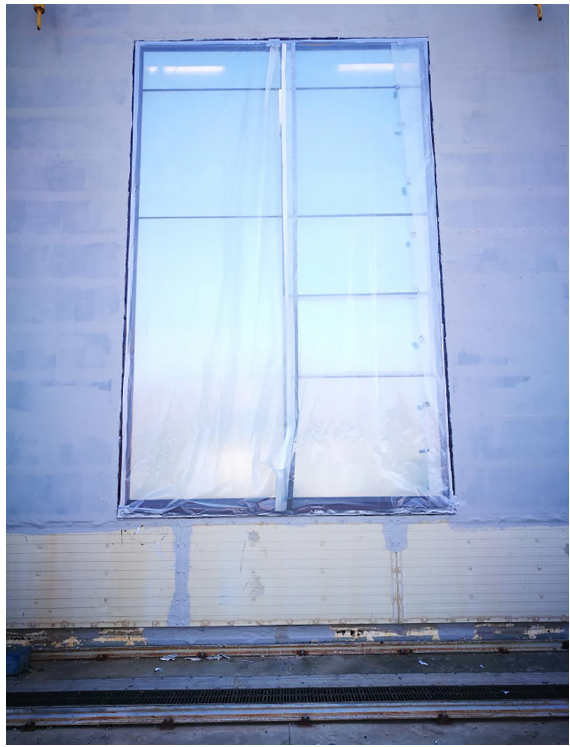
Figure 1. Air permeability test on mock-up 01.